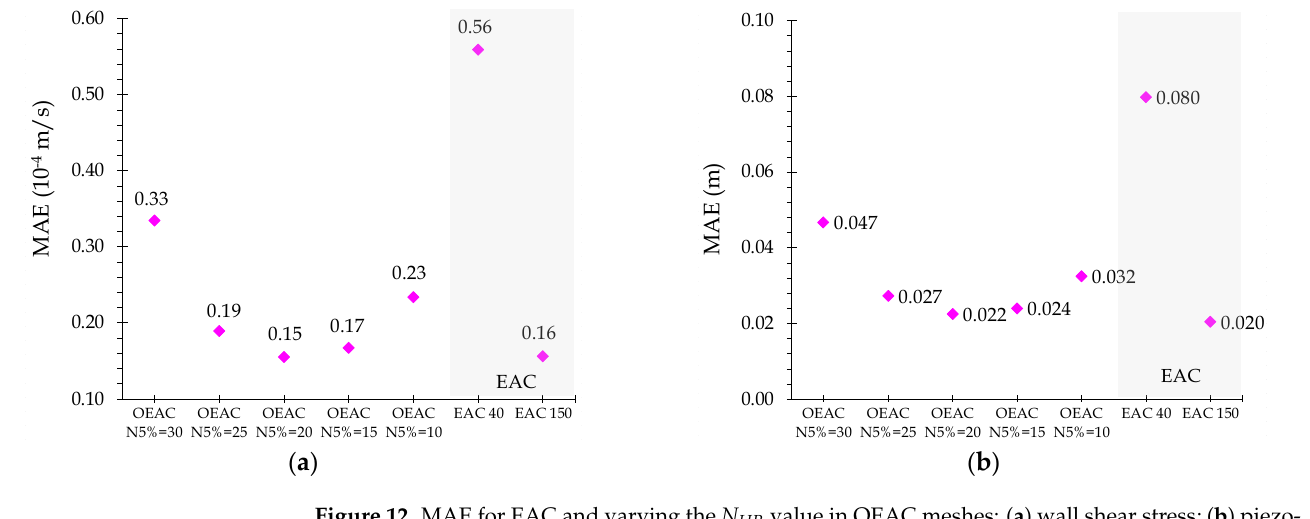
Figure 12. MAE for EAC and varying the N HR value in OEAC meshes: ( a ) wall shear stress; ( b ) piezometric head.